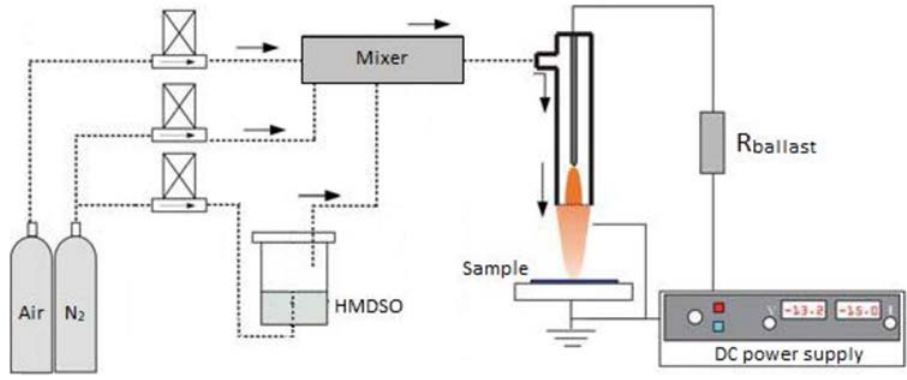
Figure 1. Scheme representing the atmospheric pressure direct current (DC) plasma deposition system.